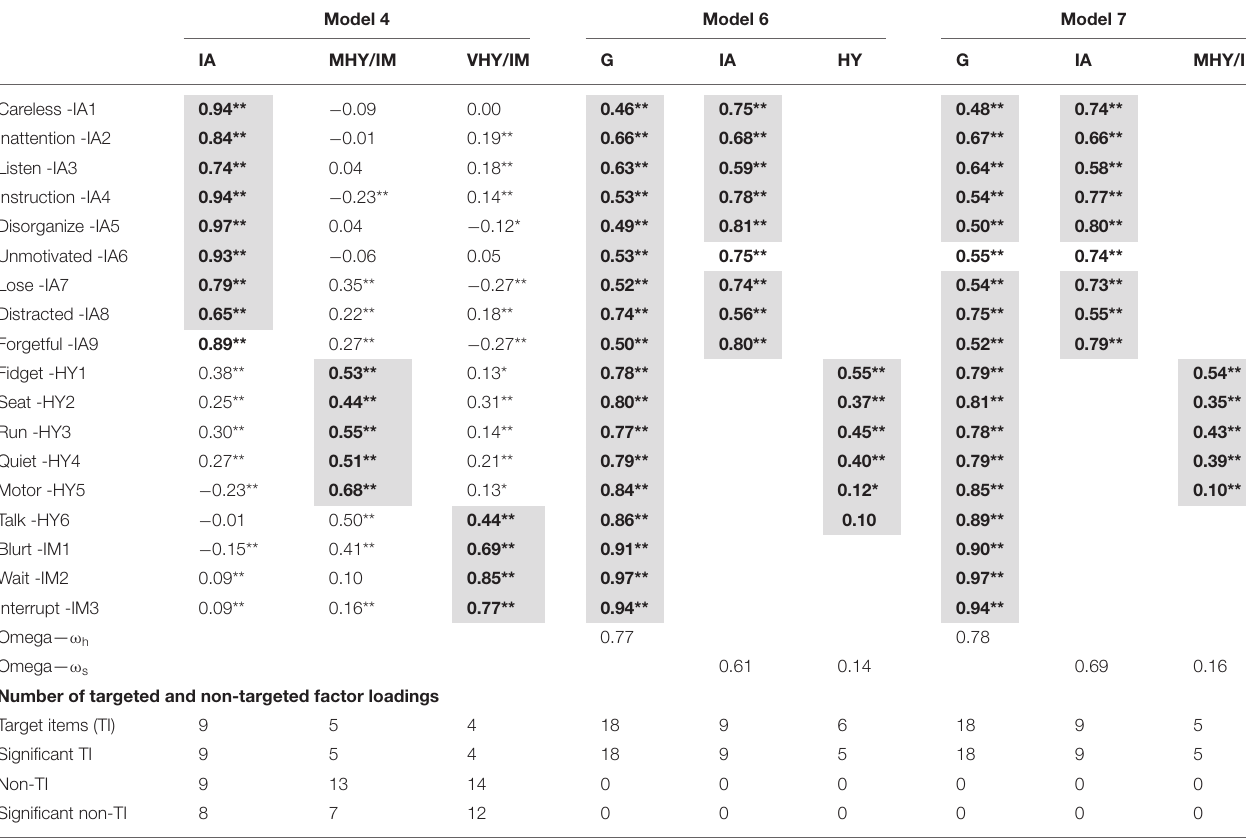
TABLE 4 | Factor loadings for models 4, 6, and 7, based on teacher